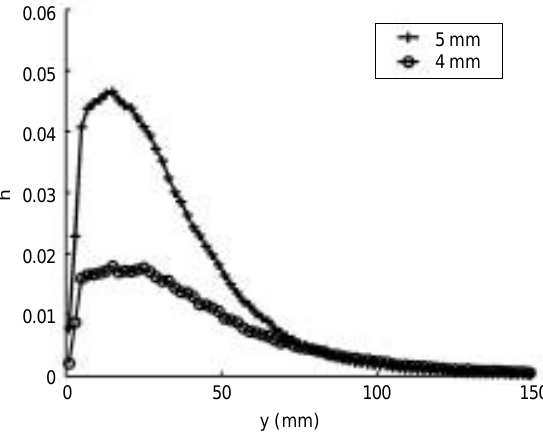
Packing fraction profiles of the two phases in the binary- size vibrated granular